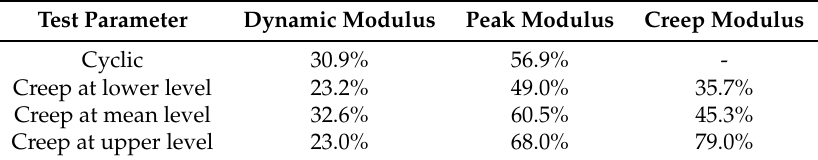
Table 1. Percentage drop of the moduli (mean values of the tests) Test